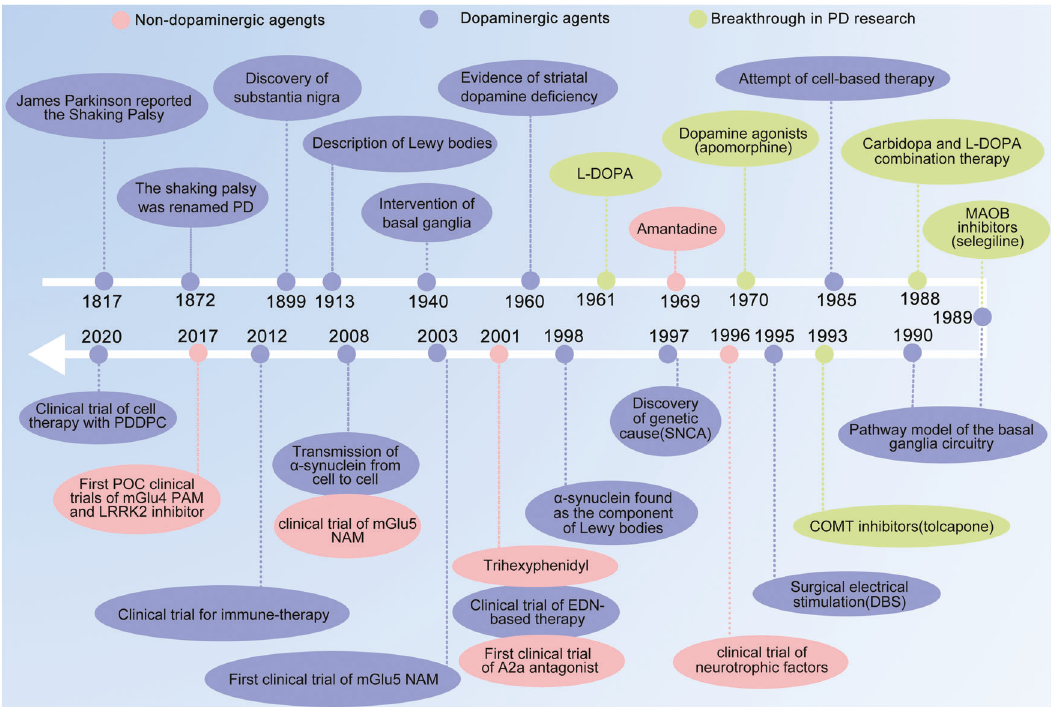
Fig. 1 Basic research and drug development history for PD disease and therapy. A2a adenosine receptor type 2a, mGlu metabotropic glutamate receptor, NAM negative allosteric modulator, PAM positive allosteric modulator, EDN embryonic dopamine neuron, PDDPC personalized iPSC-derived dopamine progenitor cell, iPSC induced pluripotent stem cell, DBS deep brain